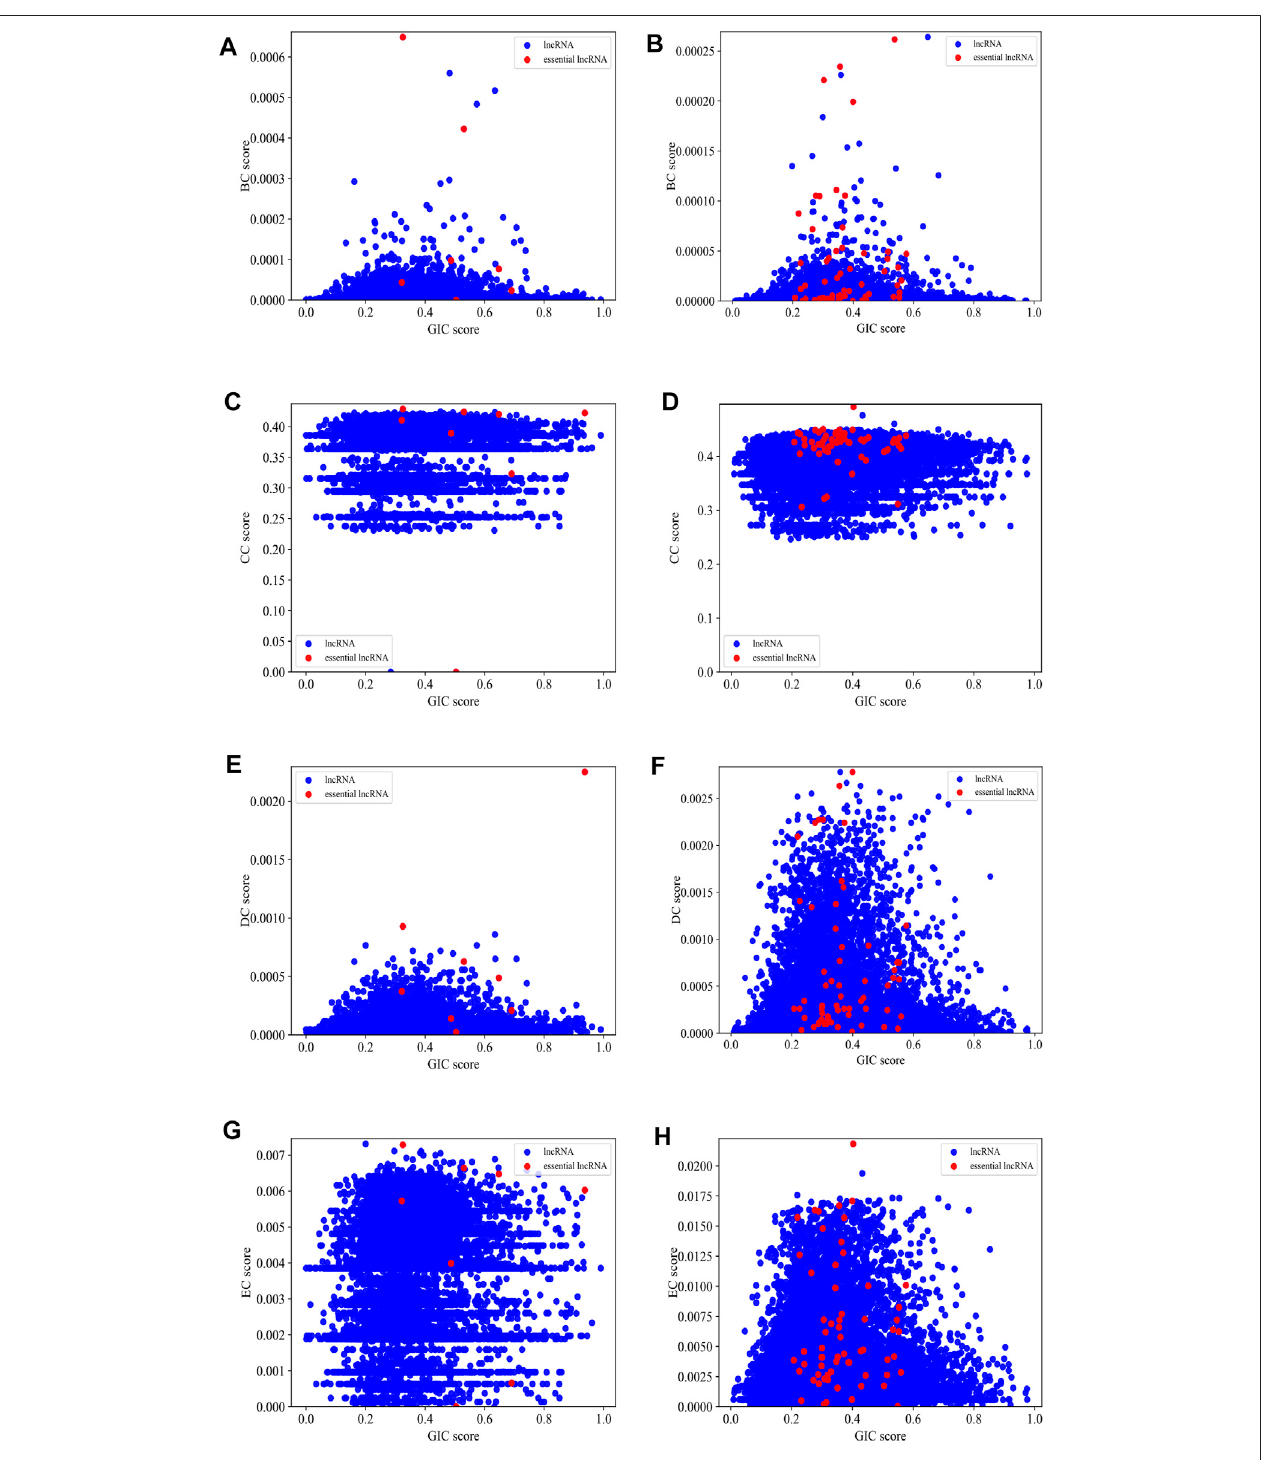
FIGURE5| ThescatterplotsofGICpairingwitheachofthefourtypesofcentralitiesonmousedatasetandhumandataset,respectively. (A) BCpairingwithGICon mouse dataset; (B) BC pairing with GIC on human dataset; (C) CC pairing with GIC on mouse dataset; (D) CC pairing with GIC on human dataset; (E) DC pairing with GIC on mouse dataset; (F) DC pairing with GIC on human dataset; (G) EC pairing with GIC on mouse dataset; (H) EC pairing with GIC on human dataset. Red dots represent known essential lncRNAs, while blue dots represented all others. When drawing panel (A), BC scores of mouse HOTAIR and Xist are too high to be plottedinthescope.Their(BC,GIC)valuesare(0.01.0.39)and(0.01.0.94).Whendrawingpanel(B), NEAT1 , MALAT1 , U1 aretoodistanttootherdots,sotheycannotbe reasonably plotted in the scope. Their (BC,GIC) values are (0.03.0.40), (0.01.0.43) and (0.005.0.54).